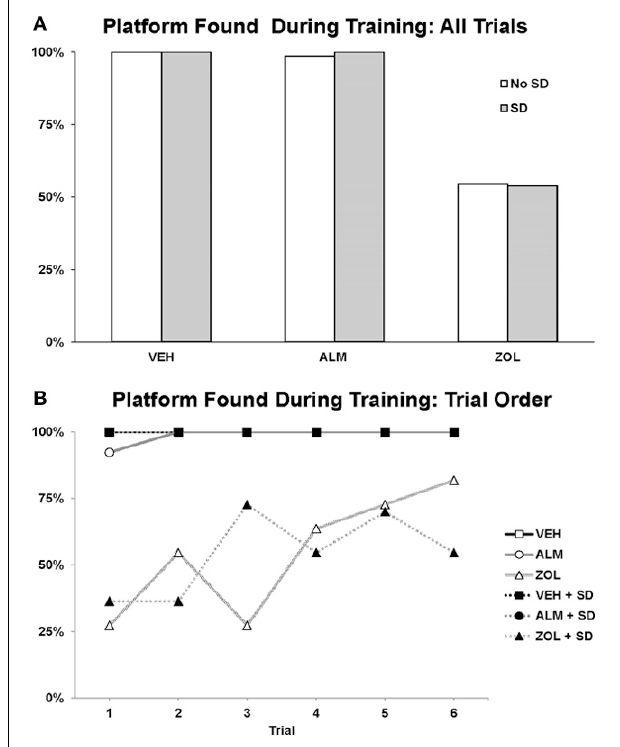
FIGURE 7 | Success rate in locating the platform during the training trials in the spatial working memory task. The platform was cued during these training trials by a flag. (A) The percentage of times the platform was found across all 6 training trials. (B) The percentage of times the platform was found trial by trial. Note that the ZOL rats tended to progressively improve across trials. In each trial, an individual rat either found or didn’t find the platform; thus, there is no variation to represent as error bars in the